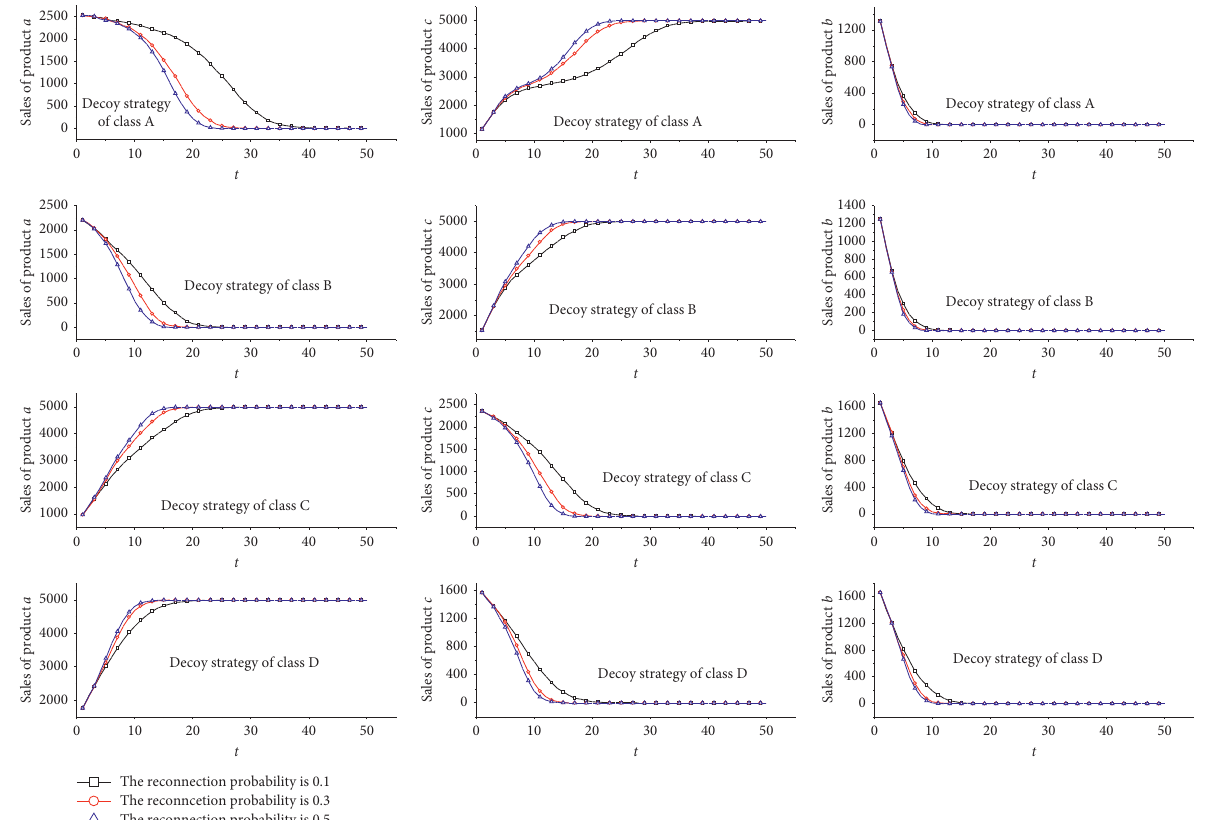
Figure 9: Evolution trend for sales of products a , c , and b under the four kinds of true decoy strategies in scenarios with different reconnection